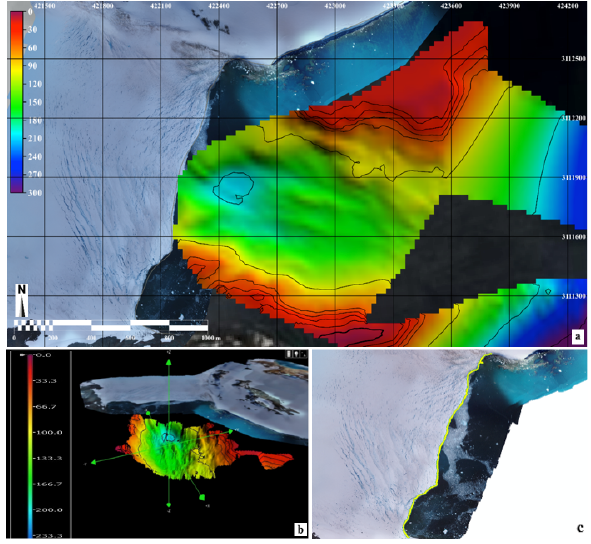
Figure 7. (a) Area of the bathymetric survey and Digital Elevation Model (DEM) in front of the Lange Glacier (LG), Admiralty Bay (AB), King George Island, Antarctica. Legend in meters. Blue ellipse in the green central area indicates the deepest point in front of the bay. (b) The three-dimensional model of LG. Legend in meters (Images obtained from CARIS Easy View (General Marítime Directorate). (c) DEM Orthophoto generated by ArcMap©10.3., in which yellow line represents the glacier front (Instituto Geográfico Nacional del